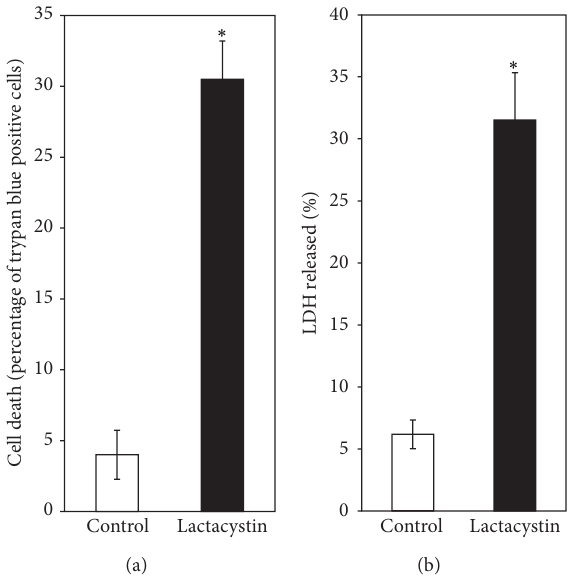
Figure 5: Effect of lactacystin on SH-SY5Y cell-viability. SH-SY5Y cells were treated without (control) or with lactacystin (5 𝜇 M) for 24 h followed by the measurement of cell viability by (a) trypan blue method and (b) activity of released LDH, as described in Section 3. Values are the means ± SD of six observations. Student’s 𝑡 -test, paired, shows significant difference ( 𝑃 < 0.001 ) in the cell viability between the treated group (M = 30.49, SD = 2.69) and the control group (M = 4.01, SD = 1.72); 𝑡 (5) = 24.23, as shown by asterisks ( ∗